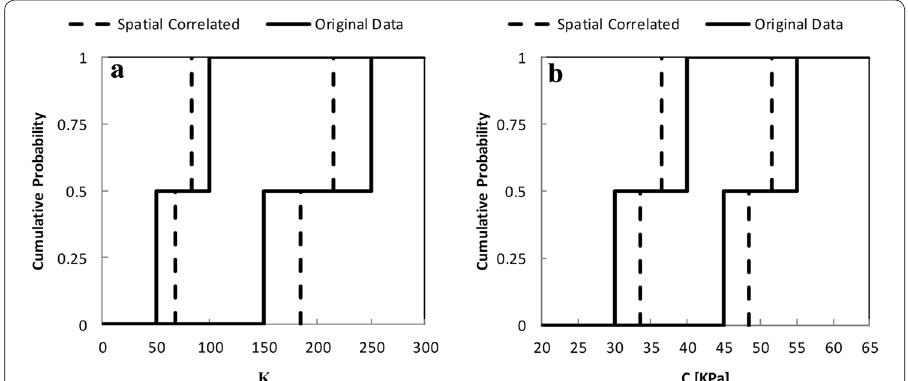
Fig. 3 Random sets of input parameter: a modulus factor of the middle layer and b cohesion of the middle